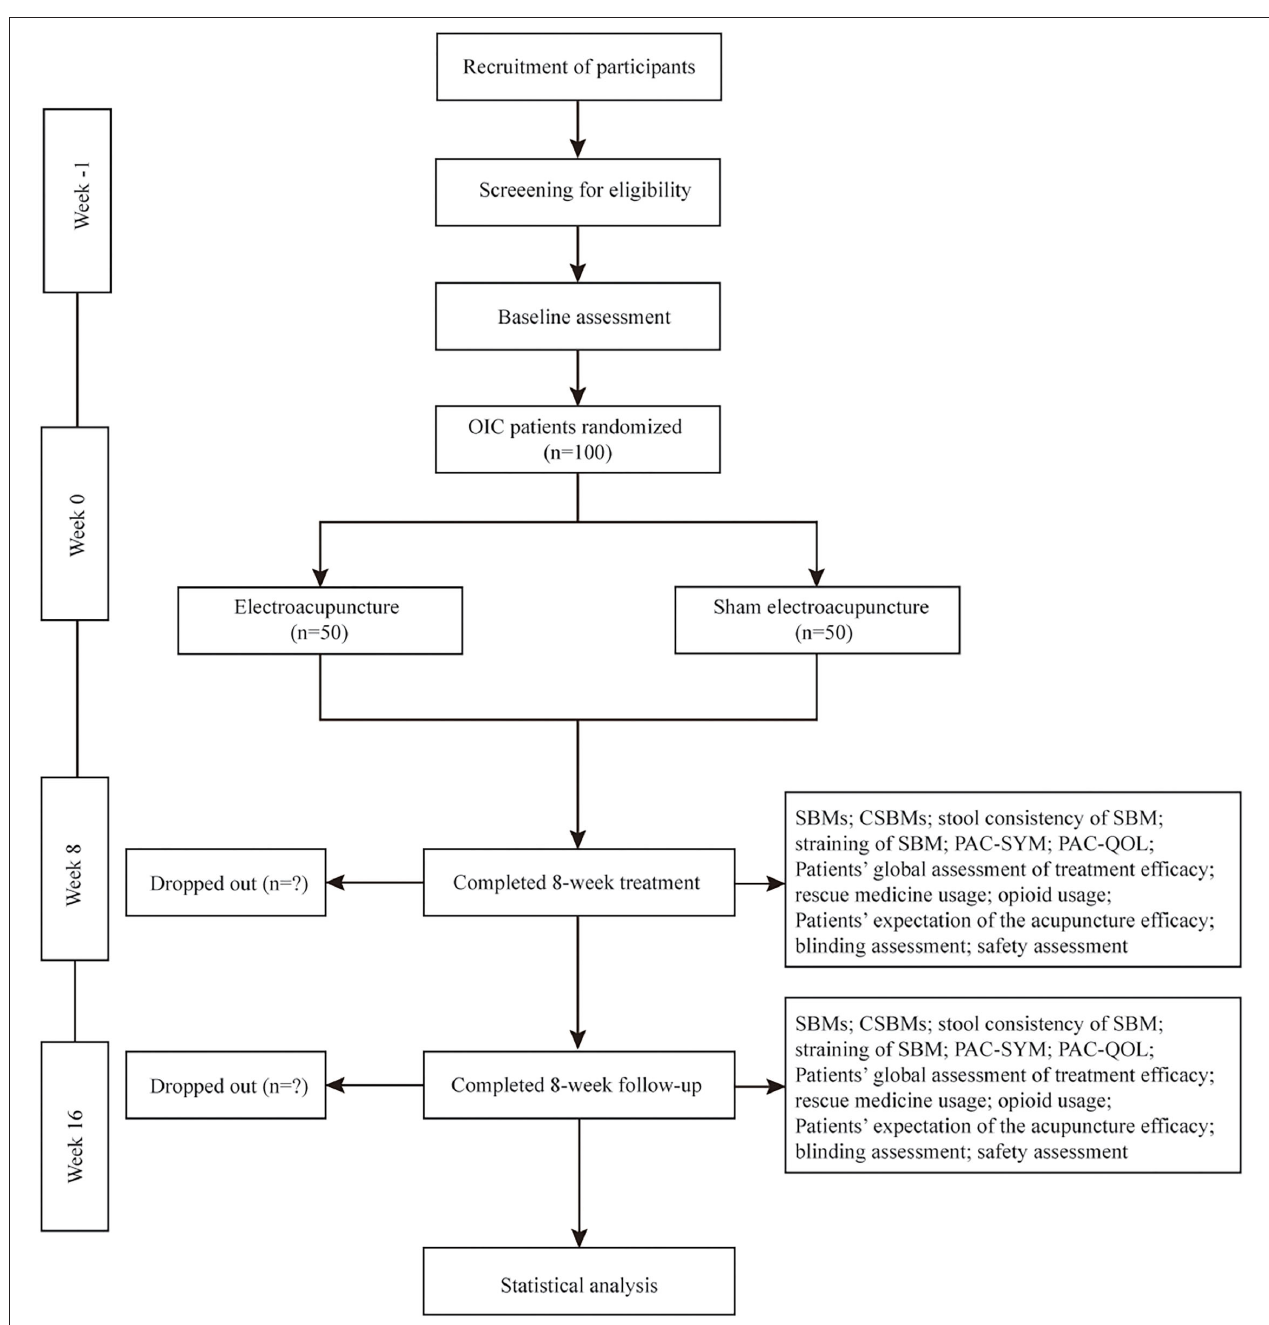
FIGURE 1 | Trial flow diagram. OIC, Opioid-induced constipation; SBMs, spontaneous bowel movements; CSBMs, complete spontaneous bowel movements; PAC-SYM, Patient Assessment of Constipation-Symptom questionnaires; PAC-QOL, Patient Assessment of Constipation-Quality of Life